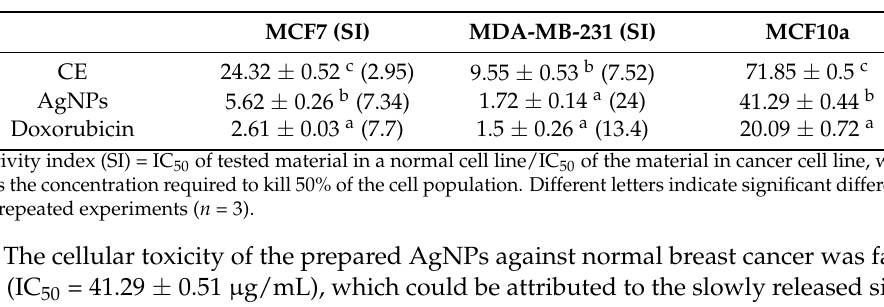
Table 1. Anticancer activity of CE and AgNPs against breast cancer and normal cell lines.